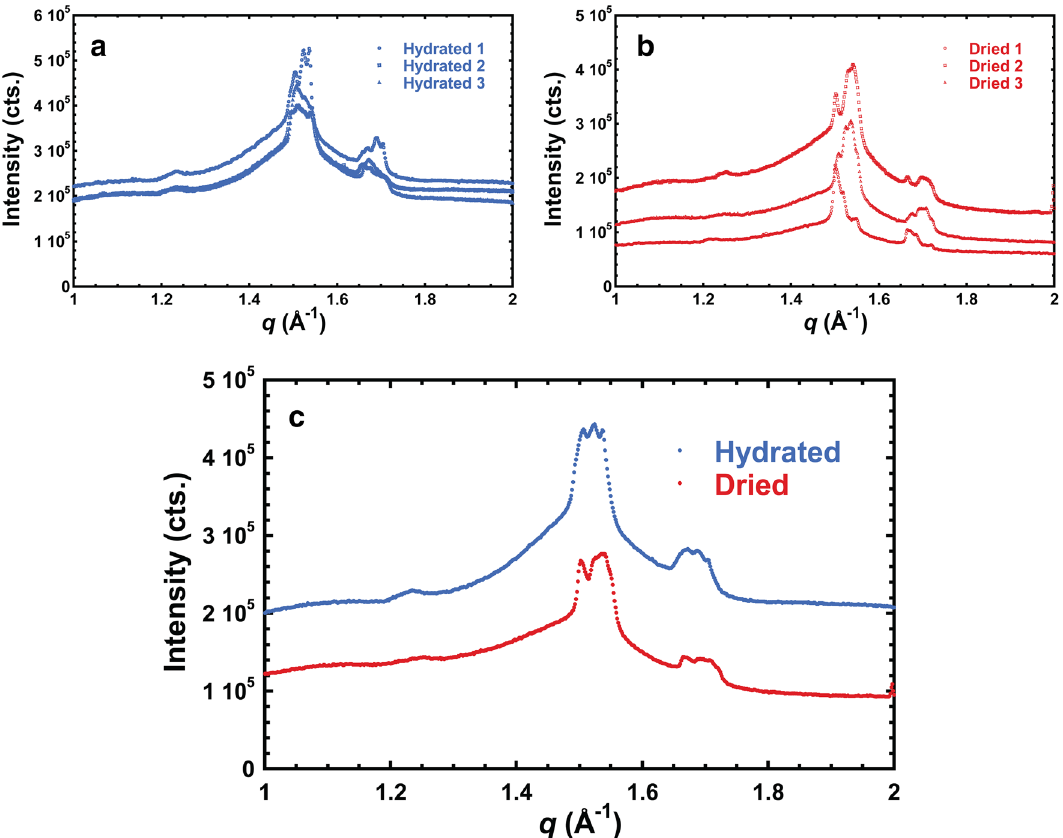
Figure 2. In-plane GIWAXS profiles of ( a ) three hydrated onion epidermal walls, and of ( b ) three dried onion outer epidermal walls. ( c ) Comparison of averaged in-plane GIWAXS profiles of hydrated and dried samples shown in ( a ) and ( b